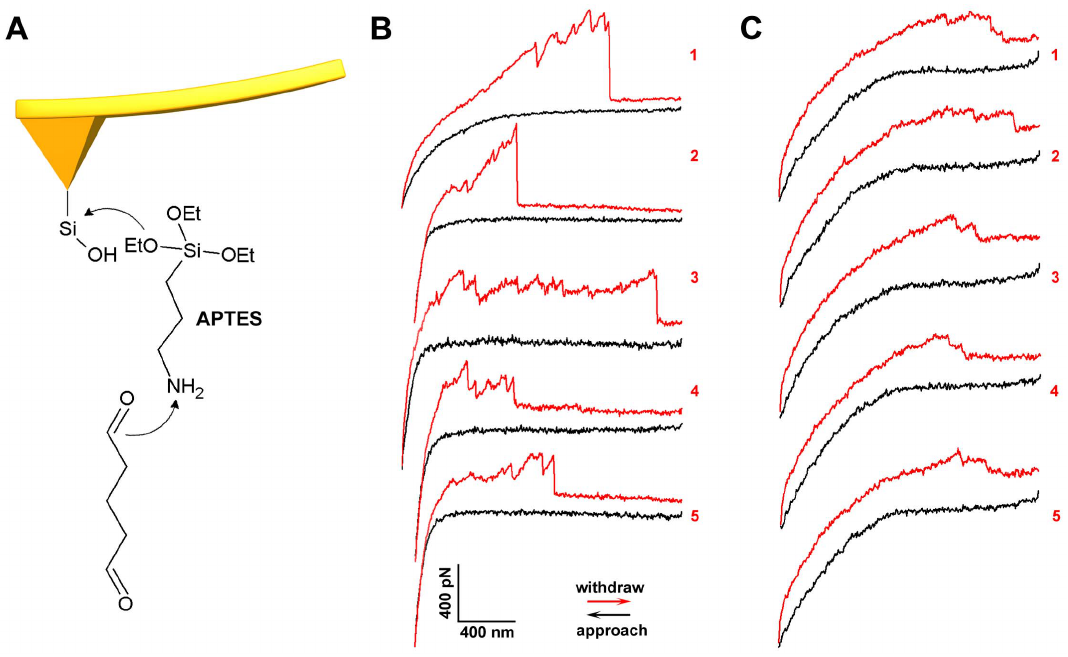
Figure 6. Detecting the amino groups on both sides of the cell membrane by single- molecule force spectroscopy. (A) The scheme of AFM tip functionalized with aldehyde group. (B and C) The typical force curves acquired on the cytoplasmic and ectoplasmic side of the cell membrane, respectively. The black and red lines represent the approaching and withdrawn curves, respectively.